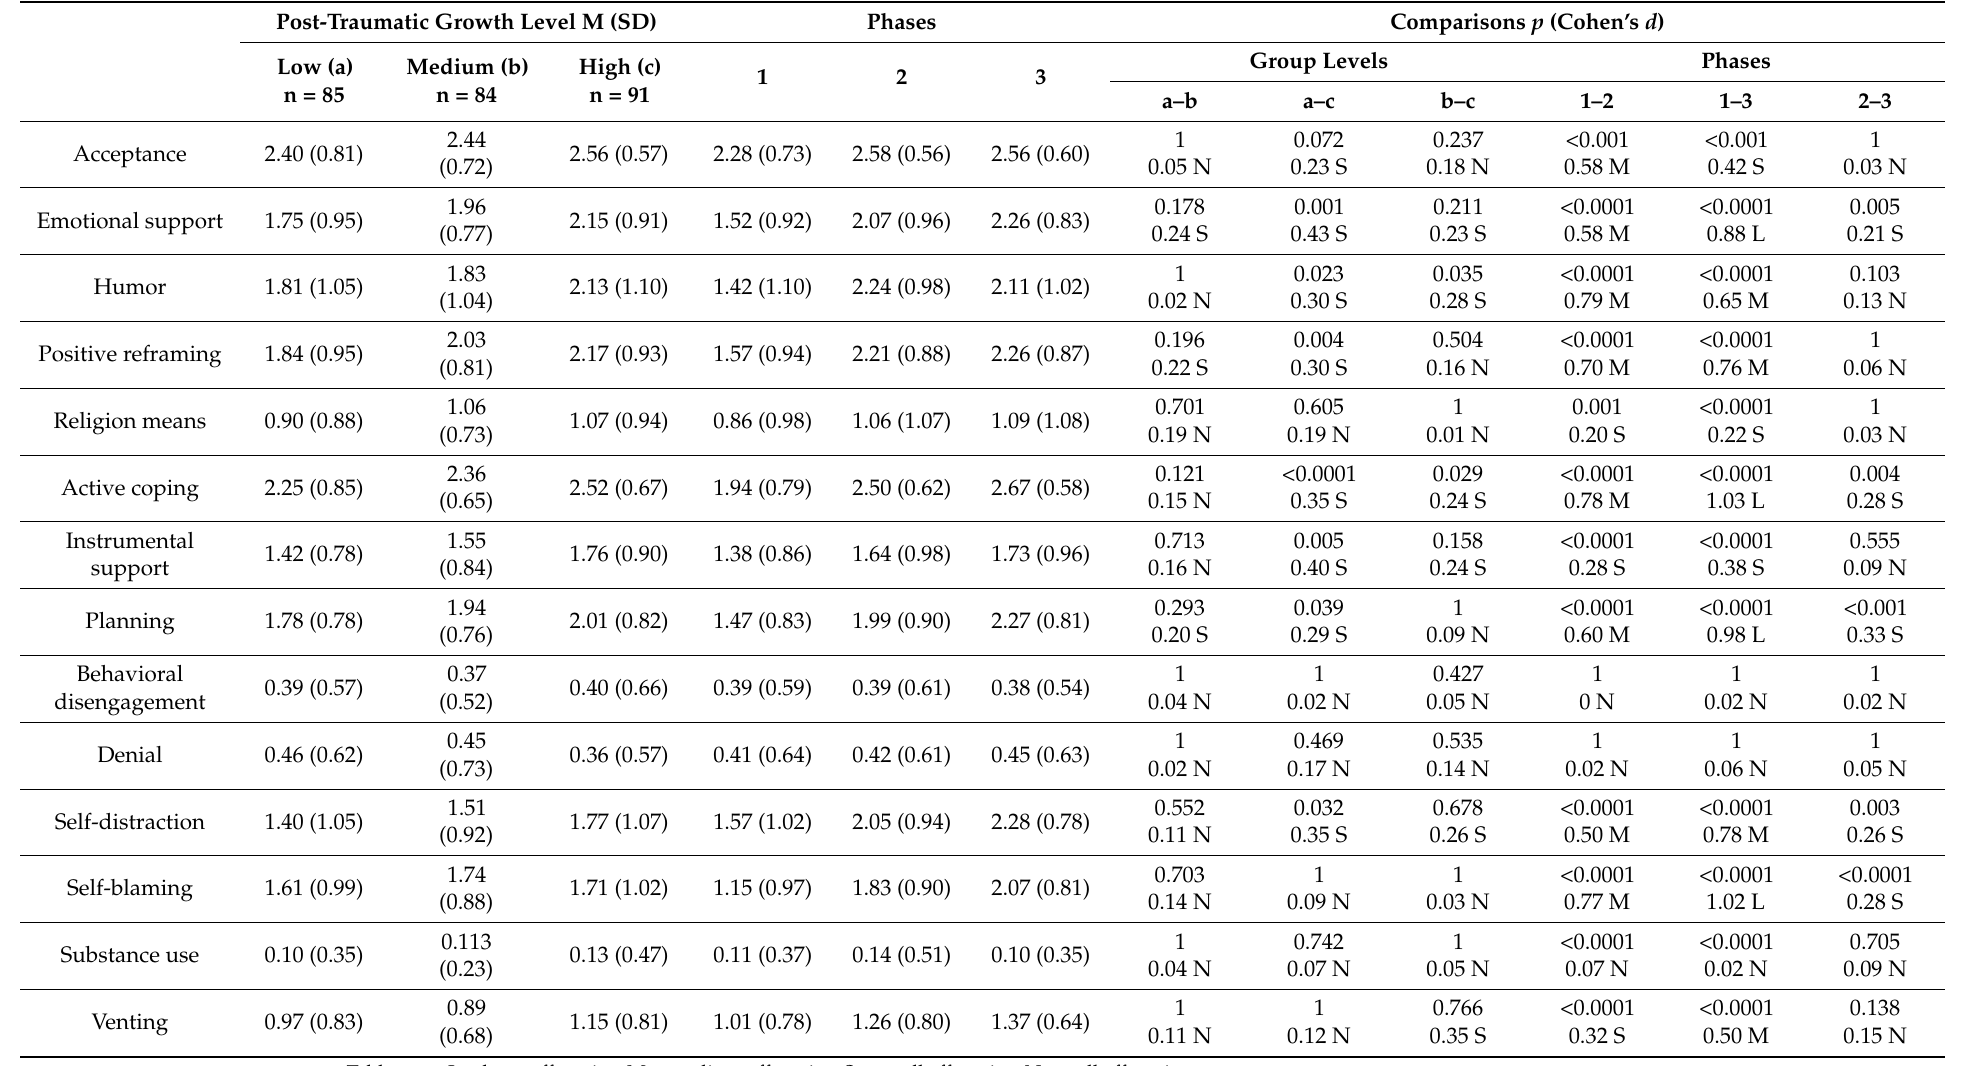
Table 3. Coping strategies: differences between coping strategies used according to post-traumatic growth level and evaluation